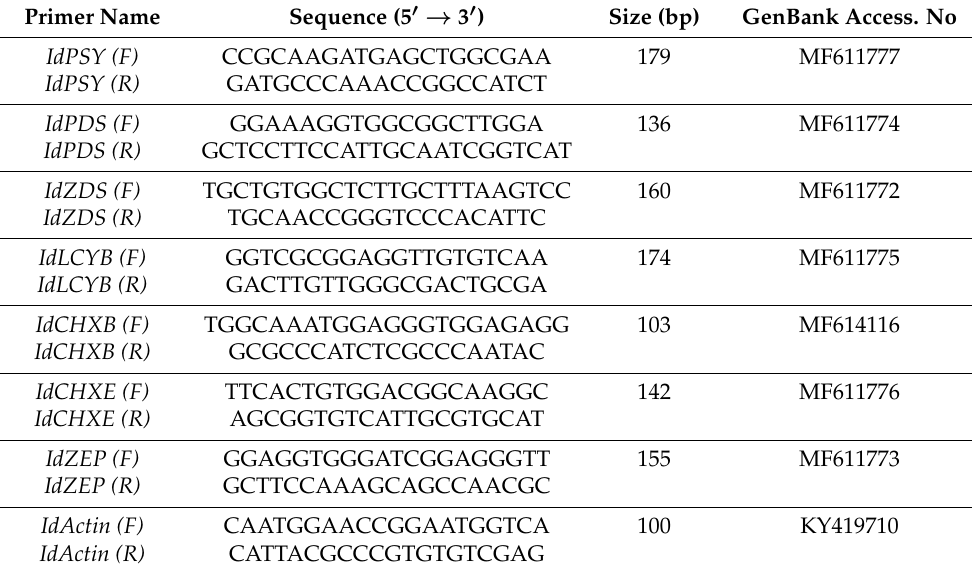
Table 2. Primers used in this